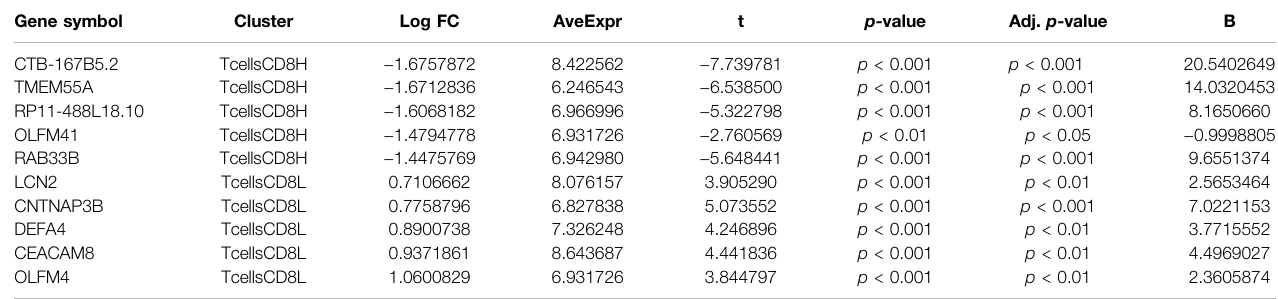
TABLE 1 | Top 10 marker genes in two clusters.